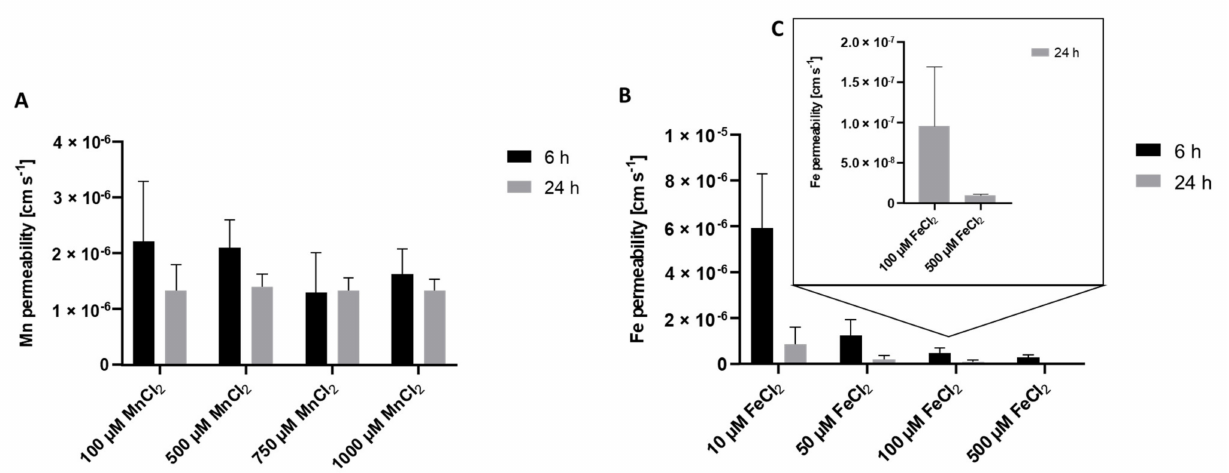
Figure 1. Basolateral Mn and Fe amounts 6 h and 24 h after MnCl 2 or FeCl 2 treatment of confluent BeWo b30 cells. Data are presented as mean ± SD of three independent experiments with two replicates each. Figures ( A , B ) show the basolateral Mn and Fe amount [%] normalized to the applied dose after 6 h and 24 h. Tables ( C , D ) show the respective basolateral amount [ µ M] exemplarily after 24 h.